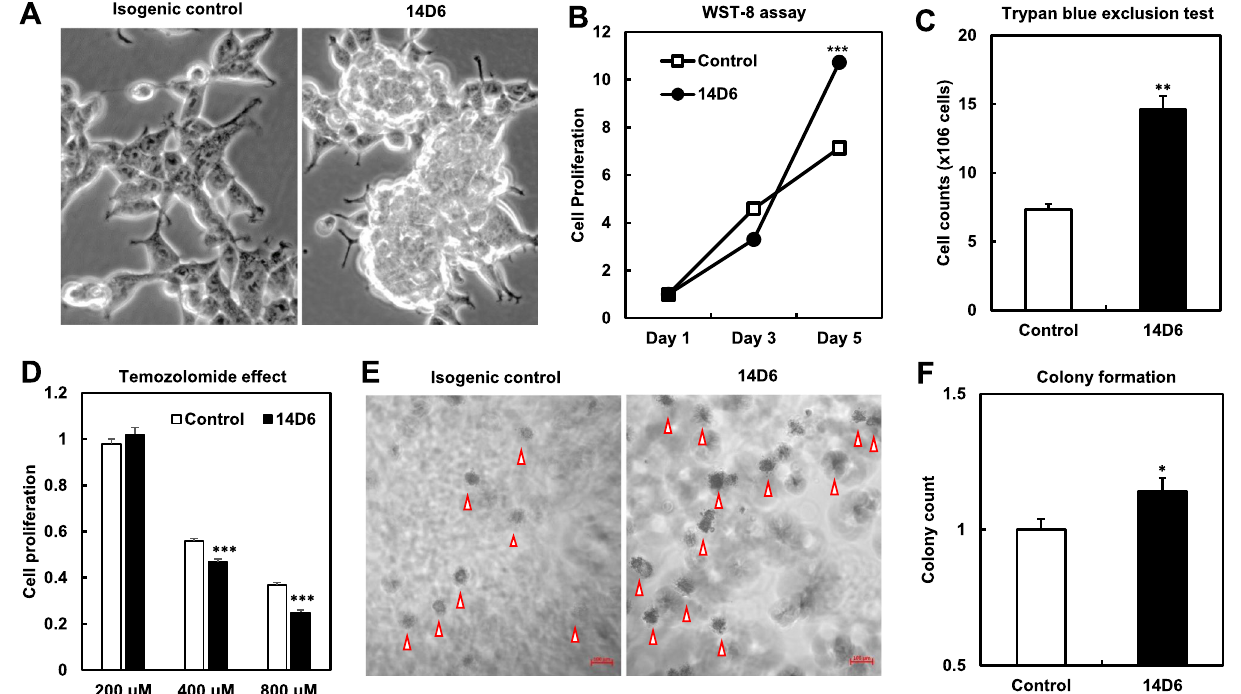
Figure 3. Phenotype analyses of PDGFRA -mutated HEK293T cells. (A) The14D6 cells showed a round morphology with a high nuclear/cytoplasmic ratio and were arranged in aggregates. ( B,C) Both the WST assay (B) and the trypan blue exclusion test (C) disclosed a higher proliferative activity in 14D6 versus isogenic control cells. ( D) The administration of temozolomide caused a higher effect in 14D6 than in isogenic control cells. ( E,F) The colony-forming assay revealed higher plaque-forming activity in 14D6 cells. Arrowheads indicate the colonies (E) . The colony quantification is shown as the count ratio of control to 14D6 cells (F) . *, p < 0.05; **, p < 0.01; ***, p <